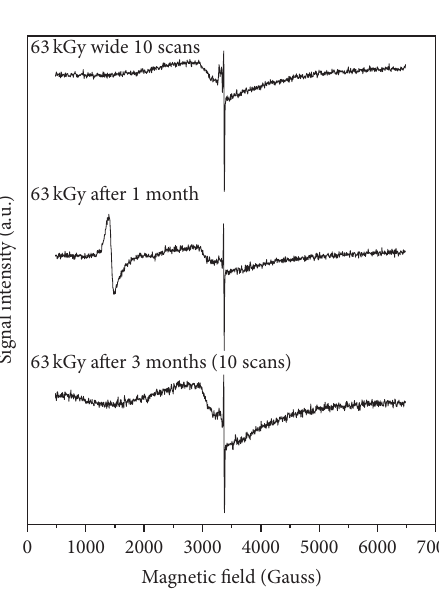
Figure 8: Variation of EPR spectra taken from wool irradiated by electron beam (63 kGy) and measured after time intervals, 7 days, 1 month, and 3 months after irradiation; EPR spectrum parameters: centre of magnetic field, 3350 Gauss, magnetic field amplitude, 1200 Gauss, and resonant frequency, 9.944 GHz, 10 scans.